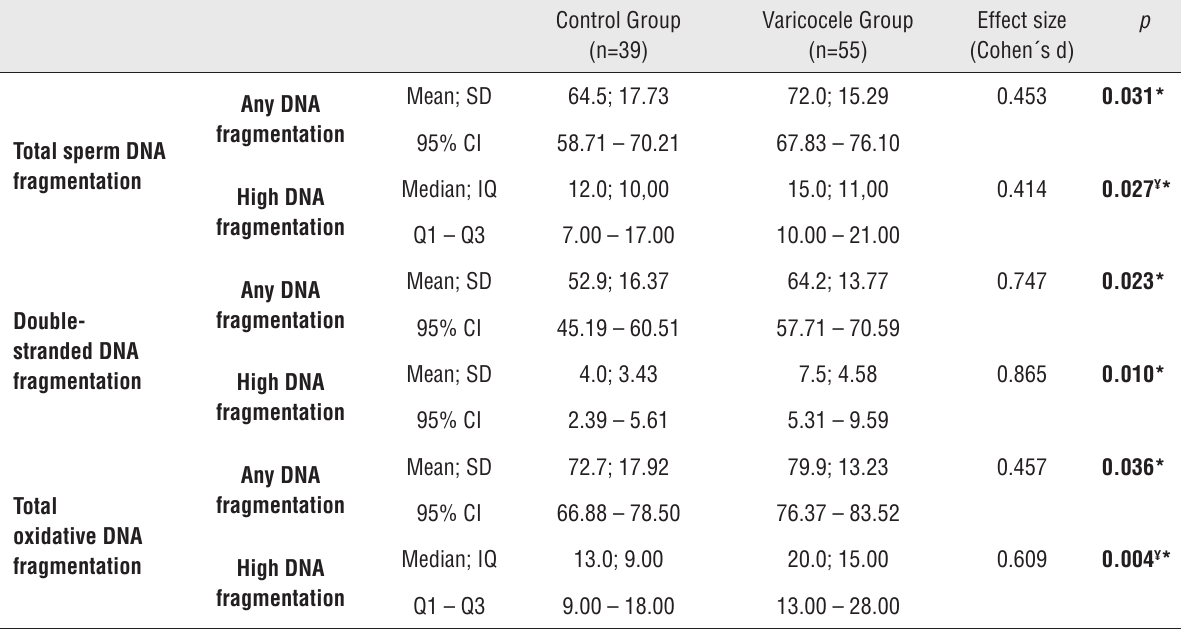
Table 2 - Sperm DNA fragmentation analyses in the Control and Varicocele groups. Total sperm DNA fragmentation (single- and double-stranded fragmentation), double-stranded DNA fragmentation, and total oxidative DNA fragmentation levels were compared using an unpaired Student’s T test, unless otherwise described ( α